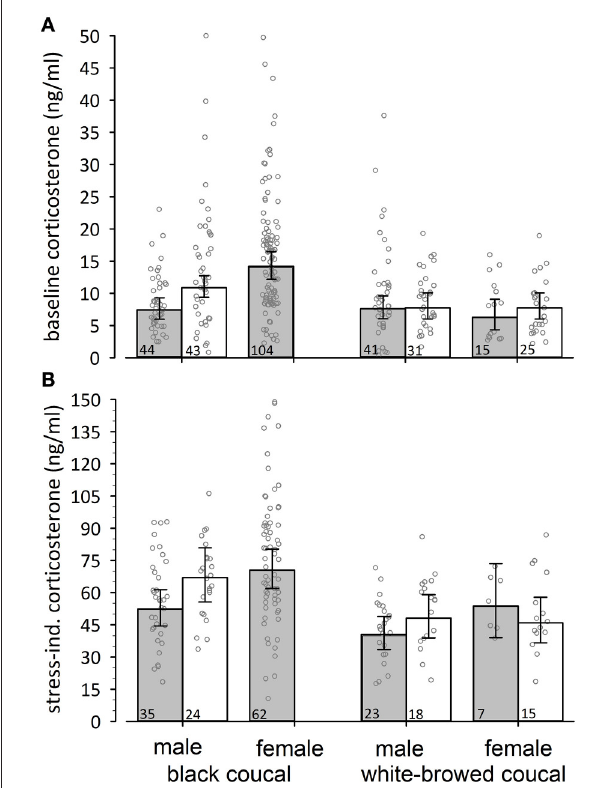
FIGURE 1 | Back-transformed posterior means ( ± 95% credible intervals) of (A) baseline and (B) stress-induced corticosterone concentrations of black coucals, and white-browed coucals outside (gray bars) and within (white bars) a parental context. If the 95% credible intervals of one group do not overlap with the mean estimate of another group one can assume a meaningful difference. Thus, male black coucals expressed higher baselines in a feeding context than outside a feeding context, whereas the baseline concentrations of female and male white-browed coucals did not differ between contexts. Female black coucals did not provision offspring and thus can only presented outside a feeding context. Their levels were higher than those of conspecific males and higher than those of white-browed coucals. Male black coucals also expressed higher levels of stress-induced corticosterone when they were feeding nestlings than outside a nestling-feeding context. In female and male white-browed coucals, stress-induced corticosterone did not differ between contexts. Breeding female black coucals expressed similar stress-induced concentrations as conspecific males in a nestling-feeding contest. Numbers inside bars refer to sample sizes, and jittered dots represent individual data points.